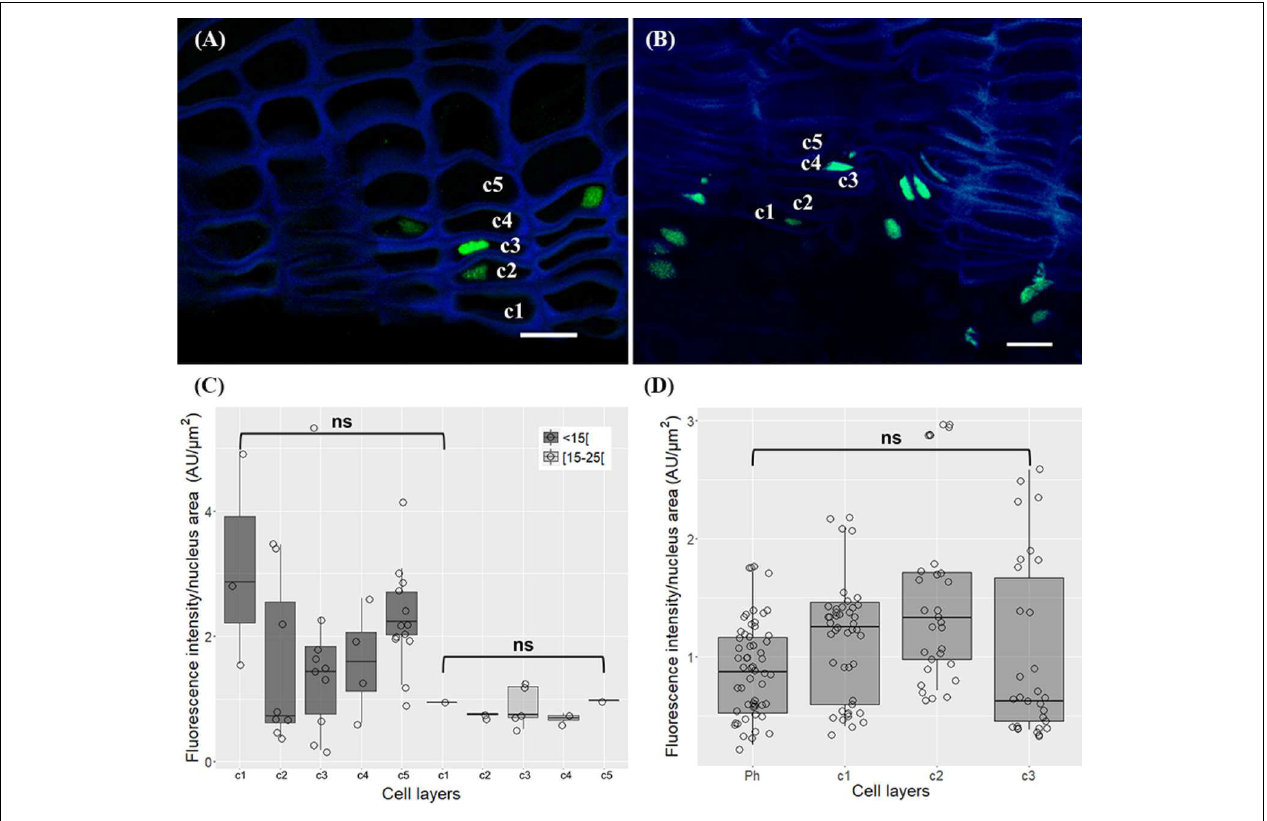
FIGURE 8 | Immunolocalization of the acetylation of histone H3 at lysine 18 (H3K18ac) in in periderms from young sprigs. Nuclei from all cork cell layers (c1, c2, c3, c4, and c5) show dispersed H3K18ac signals in one (A) and three-year-old sprigs (C) , with no significant differences detected (B,D) . DNA was counterstained with DAPI. Bar = 10 µ m. Ph, phellogen. Boxplots represent minimum fluorescence intensity/nucleus area, first quartile (bottom of box), median, third quartile (top of box), and maximum. The distribution of every individual measurement is represented by jittered